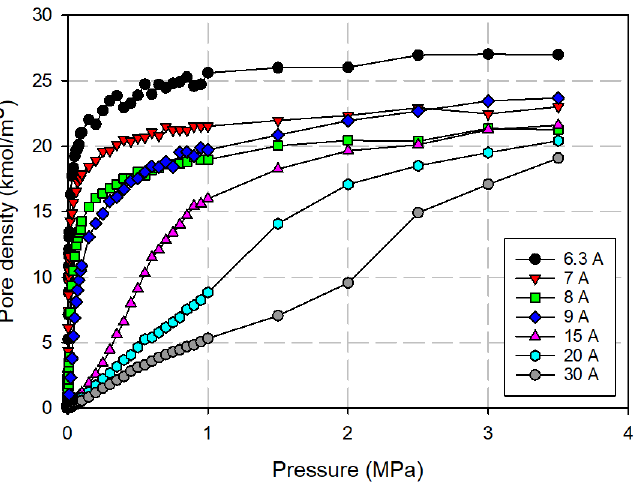
Figure 10. Adsorption isotherms of carbon dioxide obtained for a finite-length slit pore at 273 K.